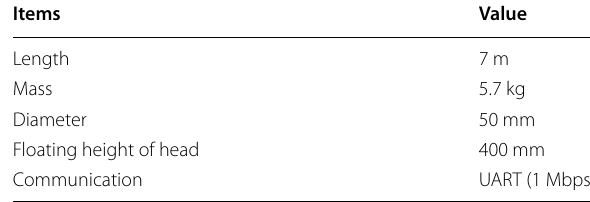
Table 1 Specifications of the